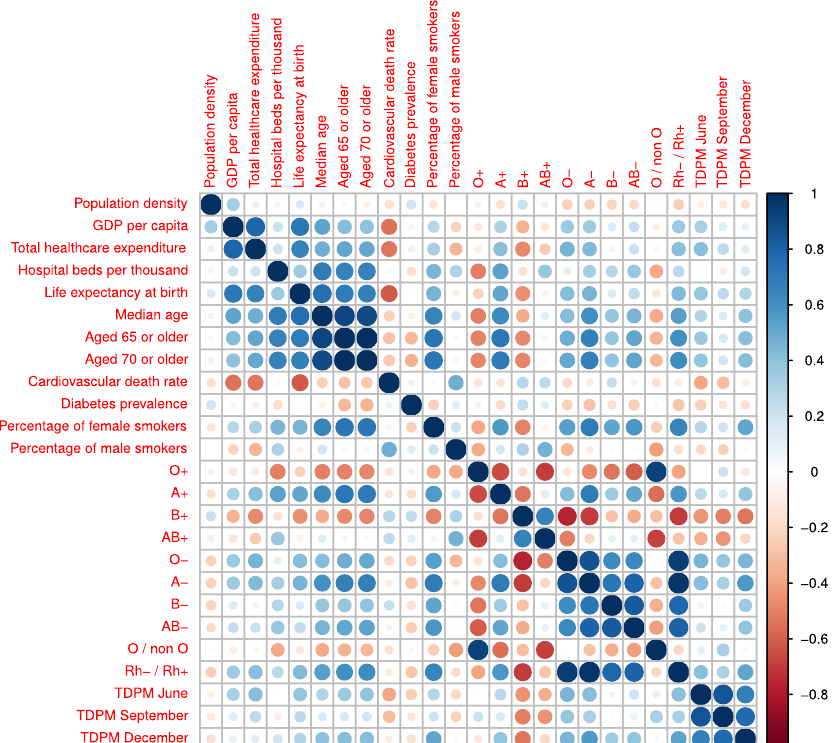
Figure 2. Correlation matrix of all variables (both dependent and independent). As expected “Median age of the population”, “Population aged 65 or older”, and “Population aged 70 or older” have mutual correlation close to 1; also the genetic features are highly correlated with each other. The TDPMs at the three different dates are also highly correlated with each other, as expected. Notably, the “B+” predictor has the highest (and negative) linear correlation with the TDPM at all three dates. R package corrplot 0.90 was used to generate the